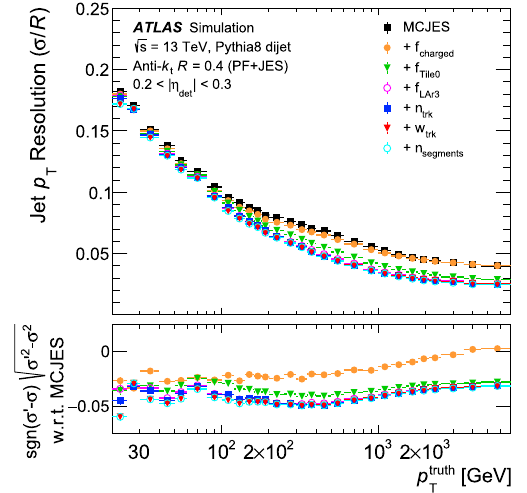
Fig. 8 Resolution of jets at the PFlow+JES scale with 0 . 2 < | η det | < 0 . 3 measured in Pythia 8 dijet MC simulation after each stage of the global sequential calibration (GSC). All jet flavours, including b -jets, are considered. The lower panel shows the difference in quadrature between the resolution before any GSC correction is applied ( σ ) and after the corresponding GSC step is applied ( σ (cid:7)